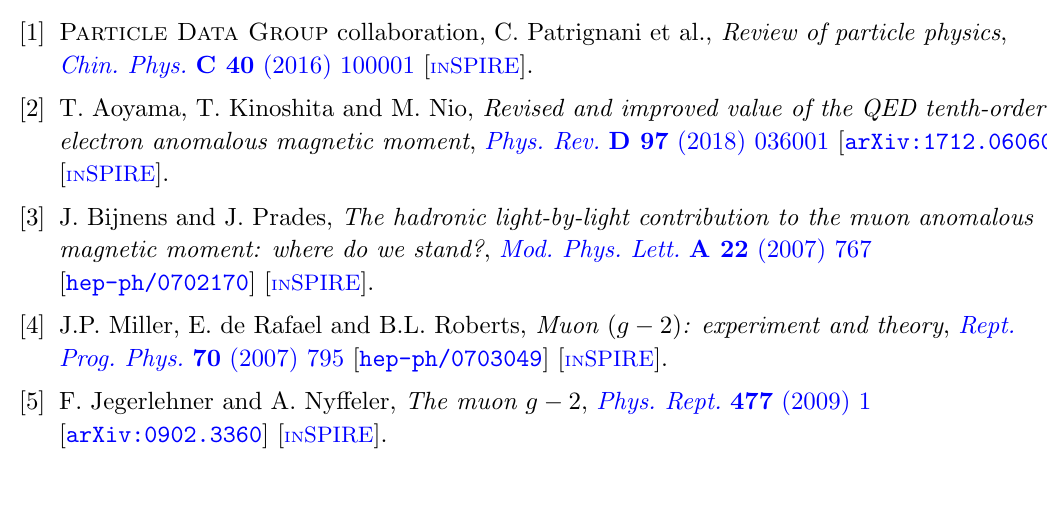
Table 15 . Correlation of (cid:12)tted parameters with (cid:12)xed M V and e V BaBar data, ‘(cid:12)t